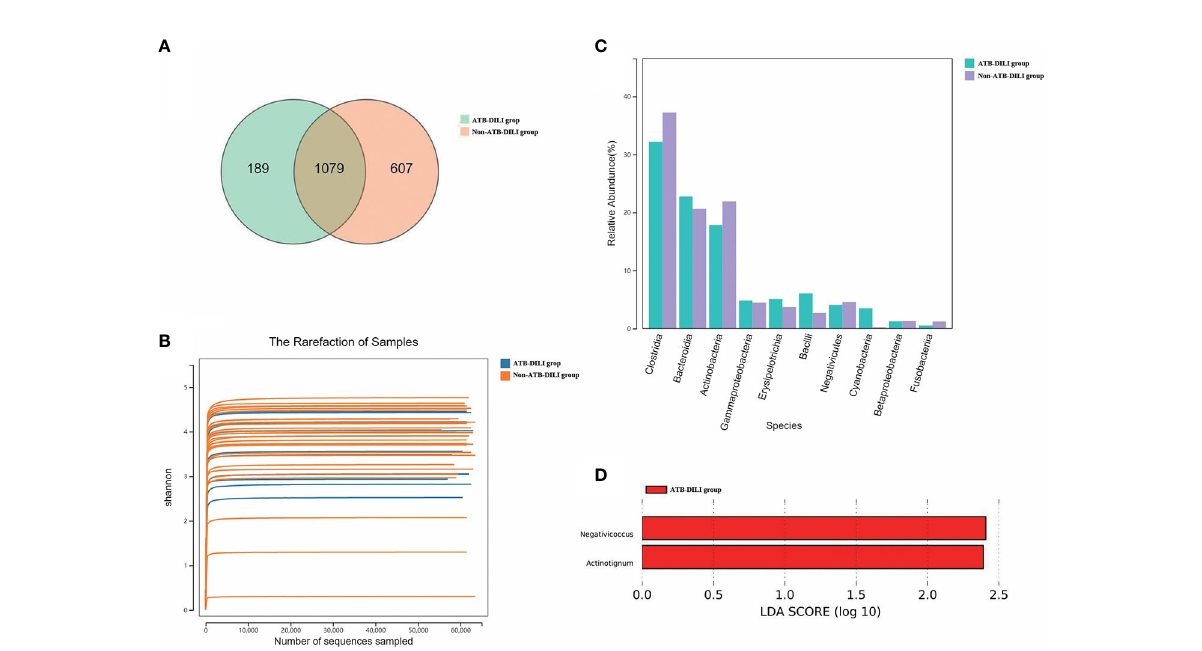
FIGURE 3 Comparison between 16S sequencing data of urine samples from non-ATB-DILI patients (n = 30) and ATB-DILI patients (n = 14). (A) Venn diagram. The left is the ATB-DILI group, the right is the control group. (B) a -diversity (Shannon curve). (C) Difference comparison of key species. (D) LEfSe analysis. Species with LDA greater than the set value of 2 are presented. The length of the bar indicates the magnitude of LDA in fl